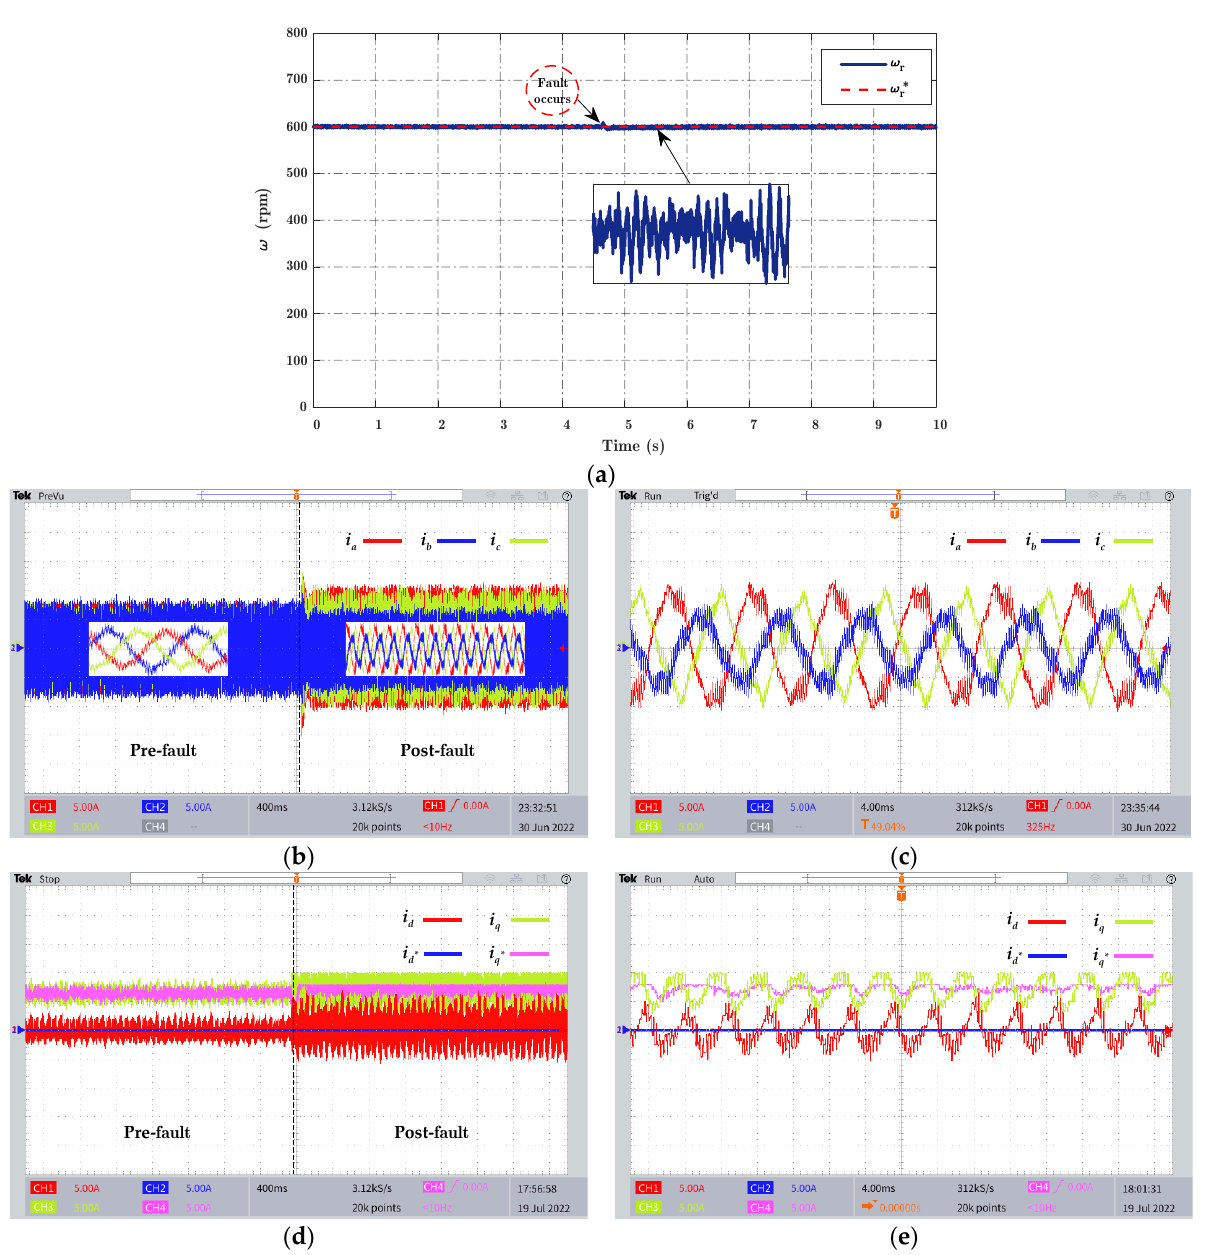
Figure 17. Electrical and mechanical characteristics in the faulty state with an LTs fault of 25%. ( a ) Rotor speed; ( b ) stator phase currents; ( c ) zoom of the stator phase currents; ( d ) direct and quadratic current component; ( e ) zoom of the direct and quadratic current component.